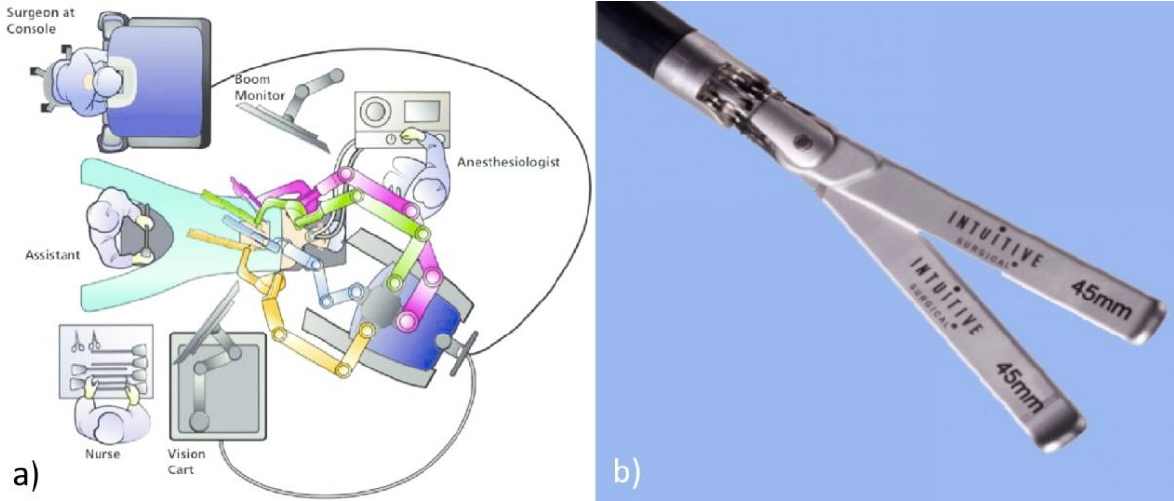
Figure 1. Retractor system used in RAMIS with the da Vinci Surgical System. ( a ) The layout in the operating room became more complicated with the introduction of the fourth PSM arm (in purple). ( b ) Endowrist retractor tool for the da Vinci. (Image credit: Intuitive Surgical Inc., Sunnyvale, CA, USA).